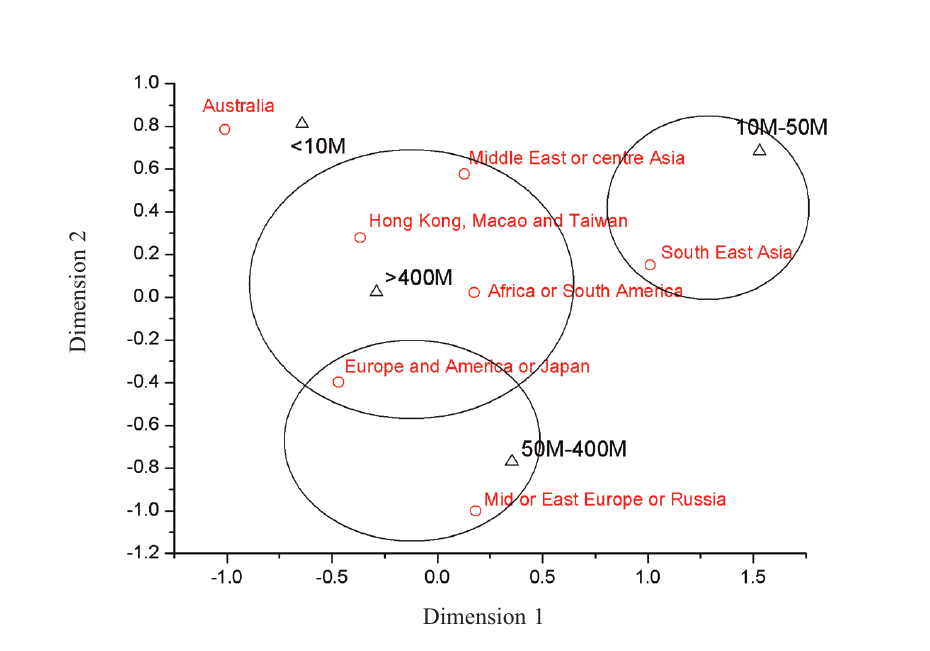
Fig. 5. Positioning maps between destination and enterprise scale (Total assets in RMB)